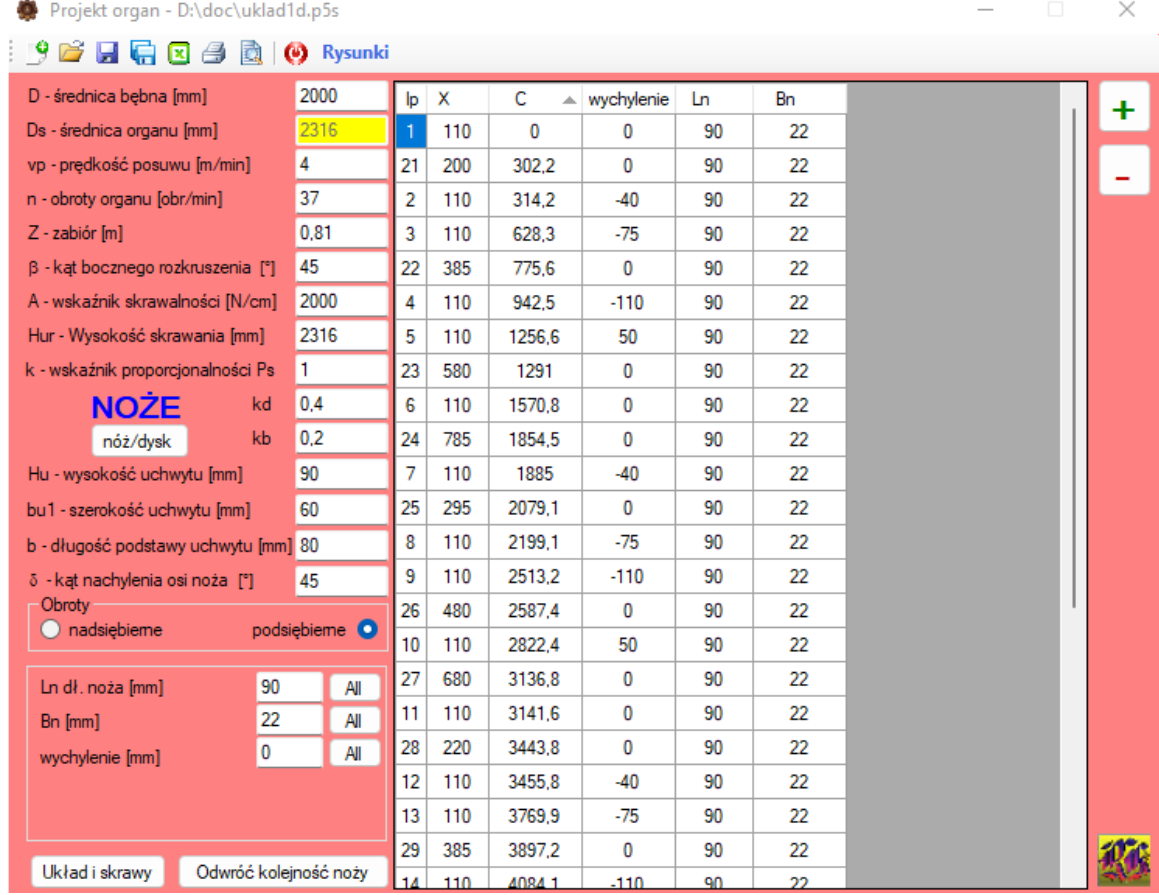
Figure 5. Main window of the program — entered data.